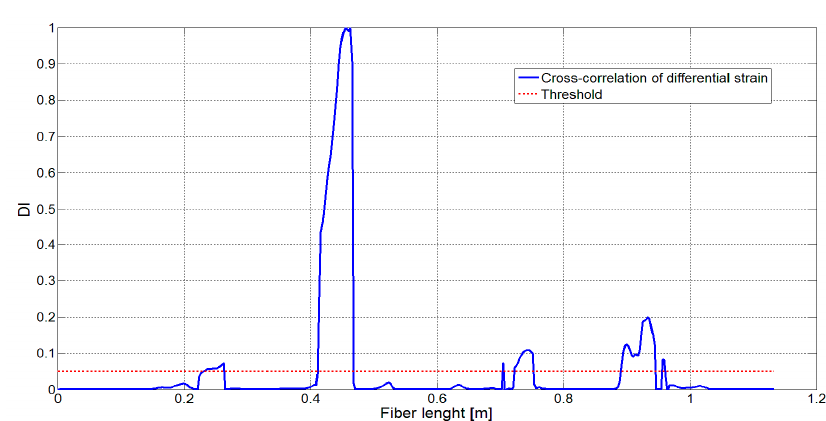
Figure 8. Differential strain after impact for PNL1.